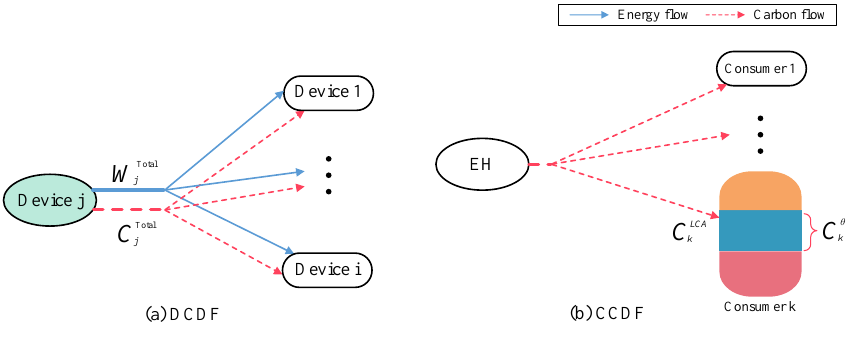
Figure 2. DCDF index and CCDF index.